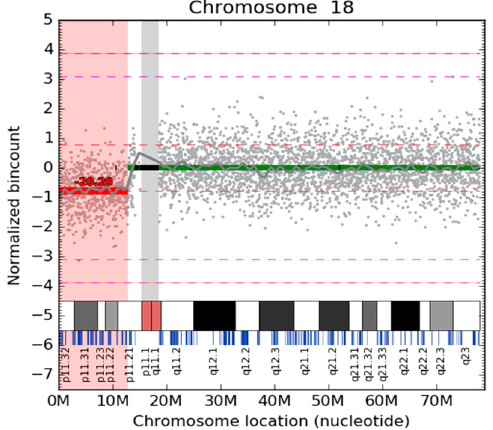
Figure 1. Visualization of CNV for chromosome 18. Normalized read counts per bin are depicted as gray dots. The red horizontal line shows the 18p11.32–p11.21 microdeletion approximately of 12.8 Mb. The light gray vertical band depicts an unmappable region around the centromere. Black horizontal bands signify bins that did not pass quality metrics and are thus excluded from the analysis. The light red region highlights the detected pathogenic region. The approximated z -score of deletion is displayed over the red segment. The estimated level of aberration detection based on the fetal fraction of this sample (12.8%) is visualized as a red dashed line, while the magenta dashed line represents the estimated level of maternal aberration detection.